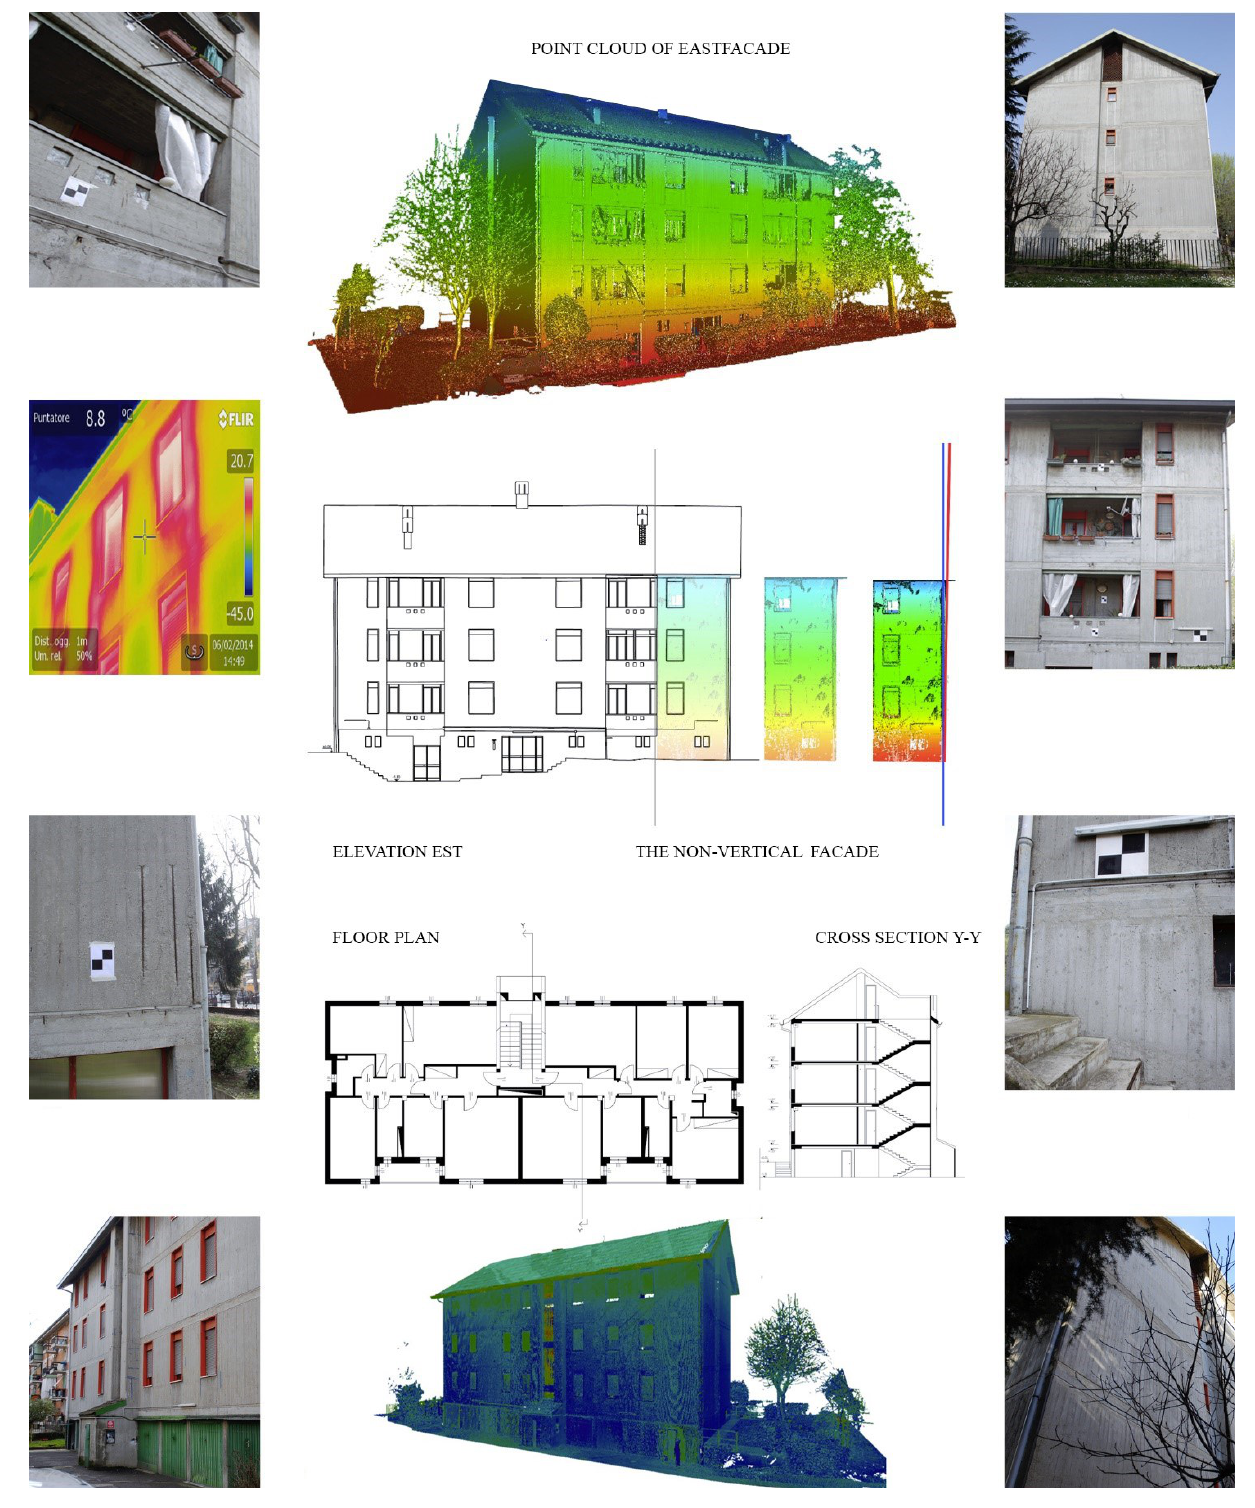
Figure 9. Demo building complexity and